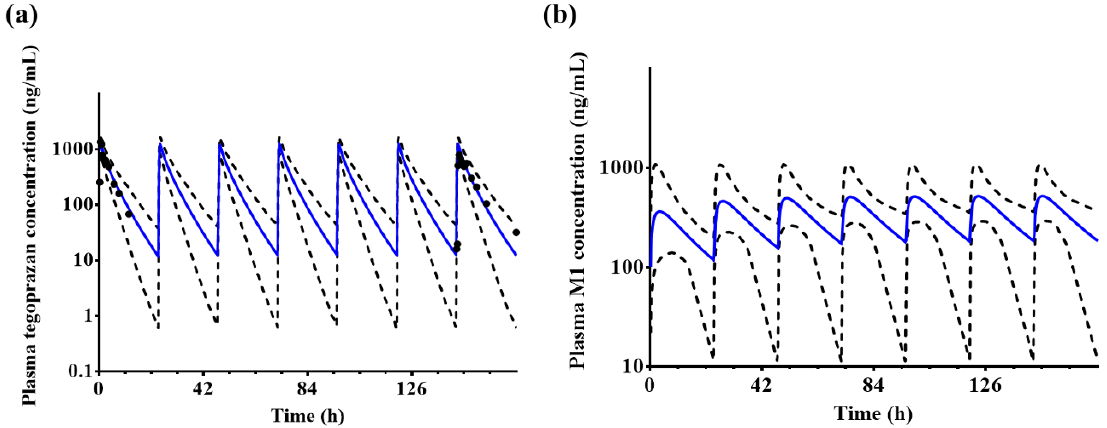
Figure 4. Predicted plasma ( a ) tegoprazan and ( b ) M1 concentration – time profiles after the repeated administration of 100 mg tegoprazan once daily for 7 days. Blue solid lines and black dotted lines represent the mean predicted plasma concentrations and the 95th and 5th percentiles, respectively. Black dots represent the observed tegoprazan concentration profiles (n = 6). Only the predicted profiles are presented for M1.